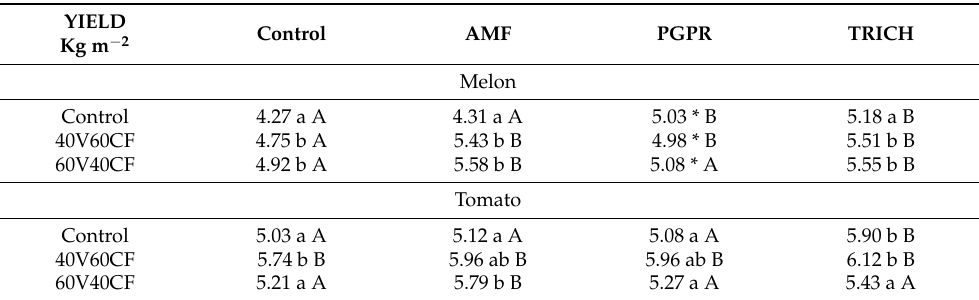
Table 5. Crop yield interactions between substrate treatments and PGPM treatments in the melon crop and the tomato